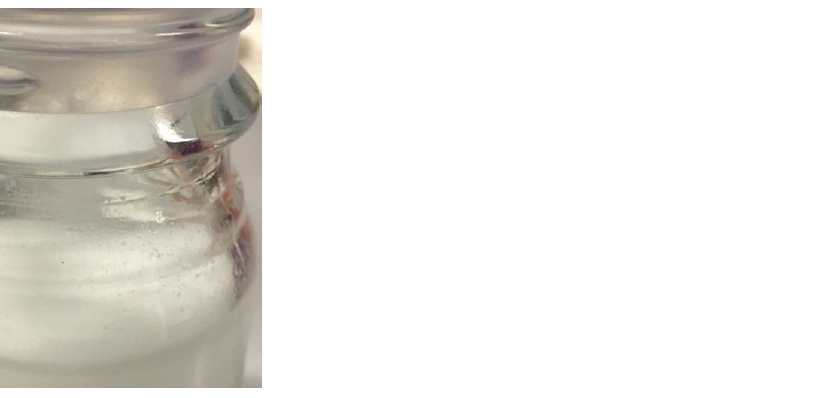
Figure A6. Image of the same suspension as in Figure A5 when stirring was stopped. The powder on top of the suspension was clearly separated from the rest of the well-dispersed suspension. After stirring resumed, the state as shown in Figure A5 was retrieved.